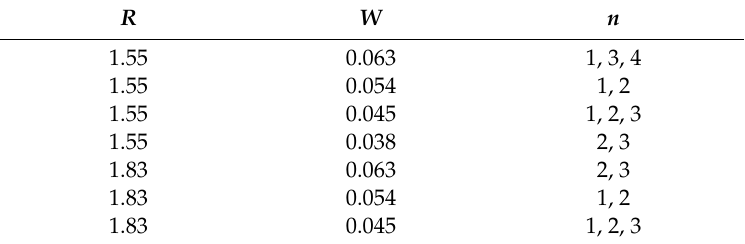
Table 1. Stall modes reported in Abdelhamid and Bertrand